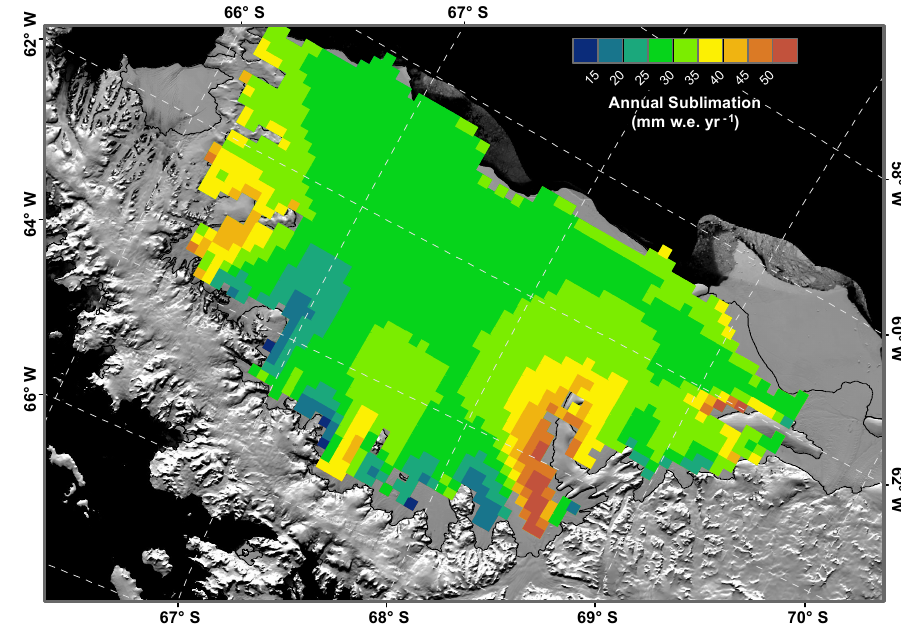
Figure 12. Annual mean sublimation (mmw.e.year − 1 ) simulated by RACMO2 over the LCIS, averaged over